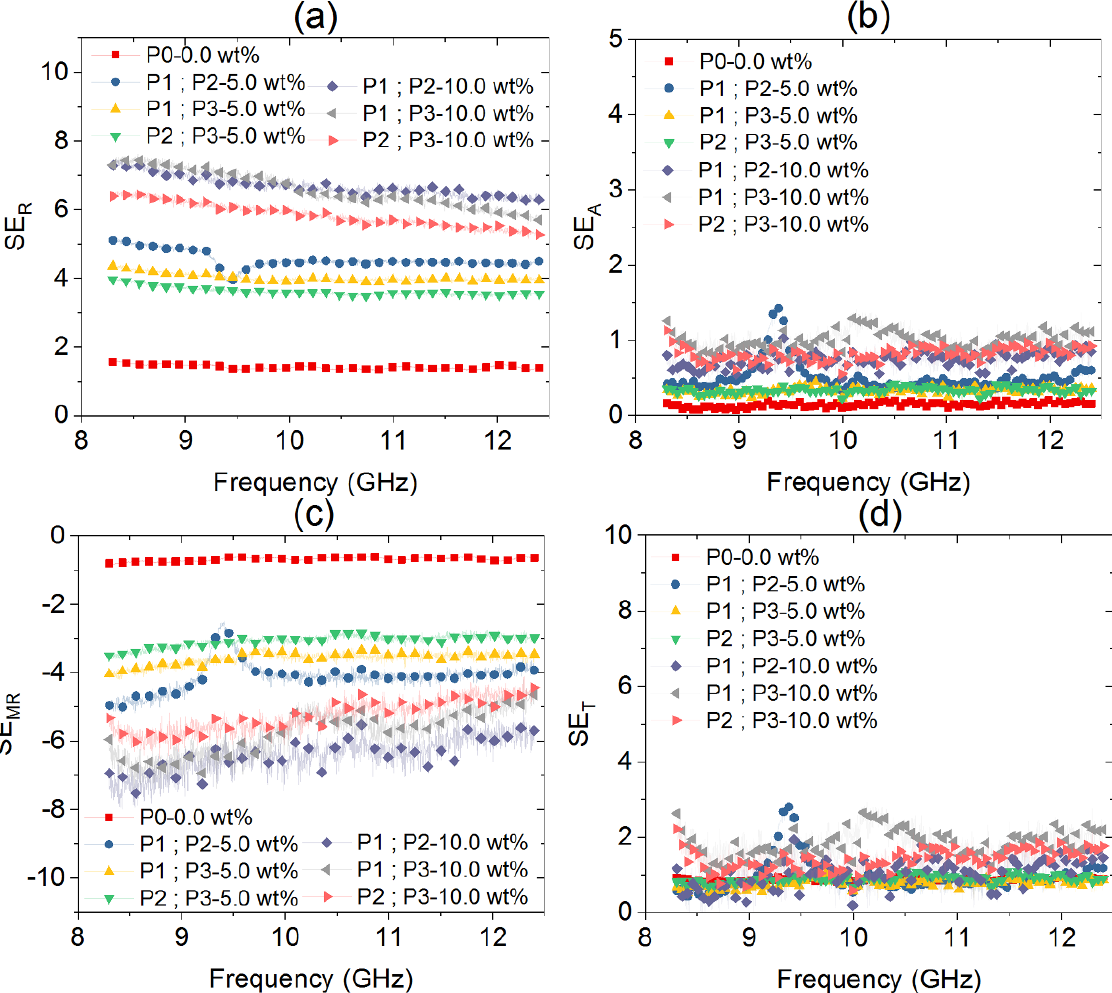
Figure 7: SE of the polymer composites with combinations of granulometry in 5.0 and 10.0 wt% of NGF. (a) SE R , (b) SE A , (c) SE MR , and (d) SE T